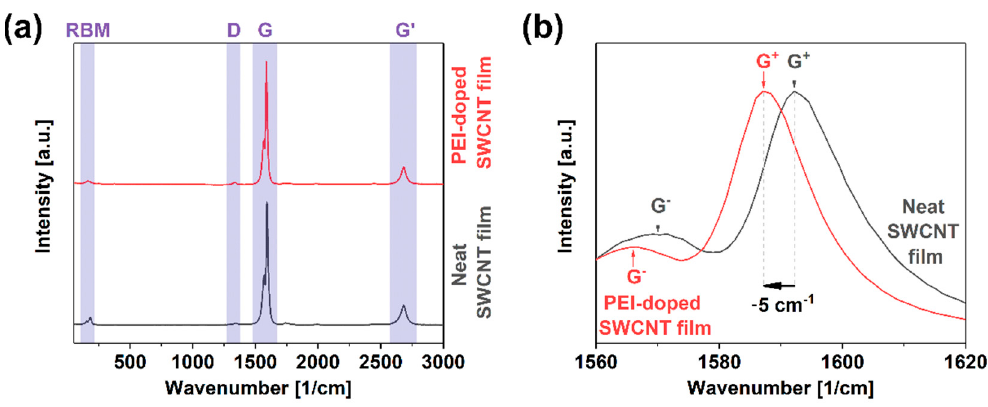
Figure 3. ( a ) Full Raman spectra of neat and PEI-doped SWCNT free-standing films; ( b ) close-up view on the G peak area.